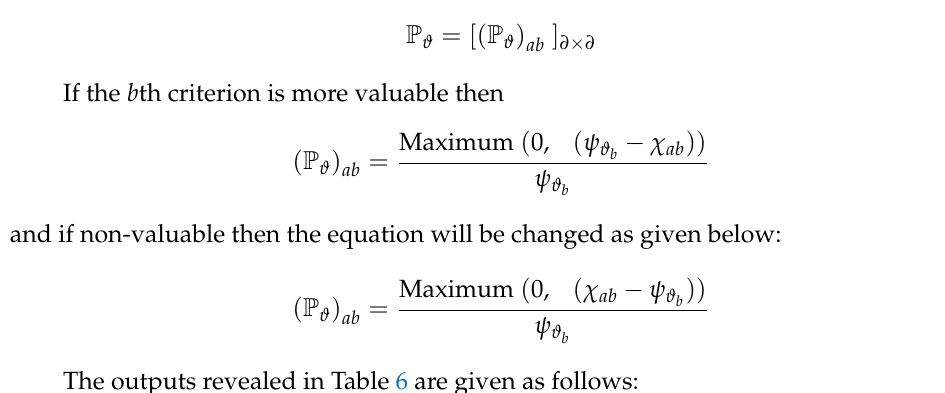
Table 6. Evaluation results of average value ( P ϑ ) . Approaches